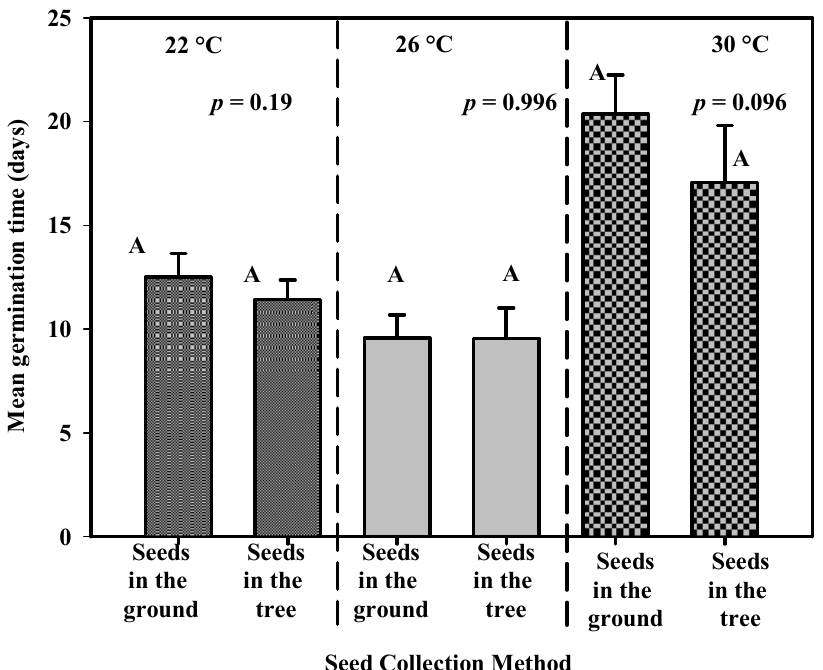
Figure 8. t -test results for the mean germination time (MGT) of D. cinnabari seeds collected from the ground and directly from the crown and evaluated for their germination at temperatures of 22 °C, 26 °C, and 30 °C. Means with the same letter are not significantly different from each other ( p = 0.05).